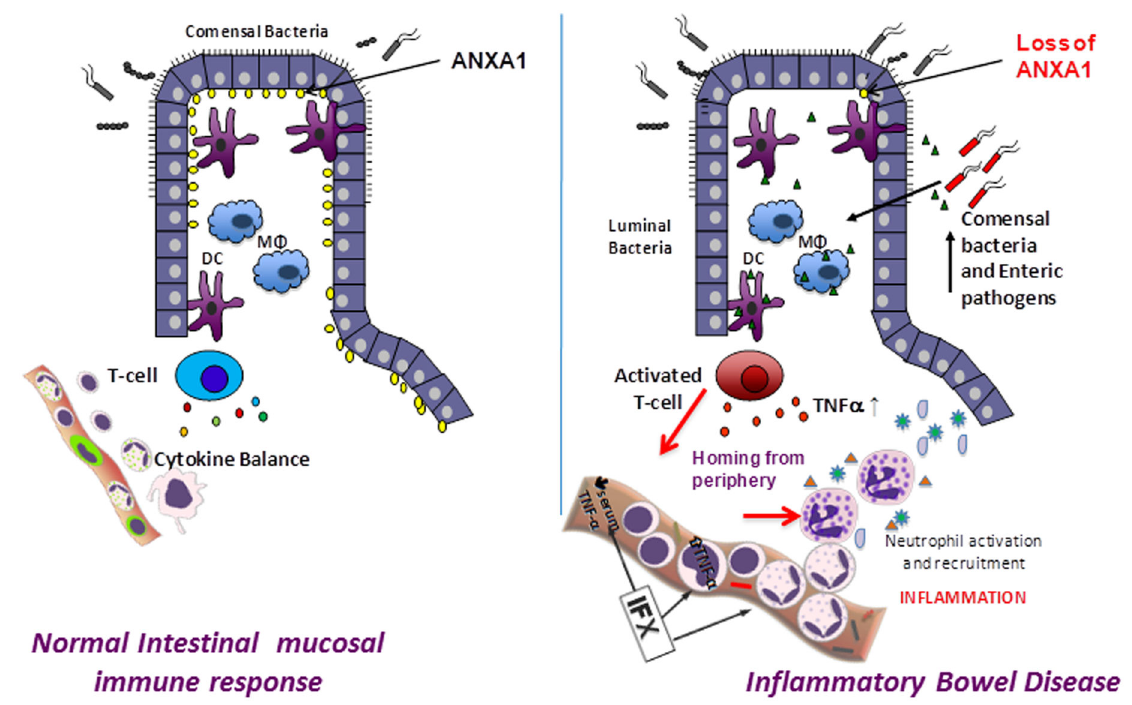
Figure 7. Proposed mechanism. The gut in an IBD patient is affected by the interplay of several factors including host microbe interactions, immune system defects/hyperactivity and dysfunctional epithelium. The loss or down regulation of Annexin A1 at the epithelial surface contributes to the epithelial dysfunction and immune modulation allowing for increased microbial translocation and increased inflammation despite IFX therapy. In positive regulators an increase in ANXA1 expression may improve control of inflammation with a reduction in symptoms. doi: